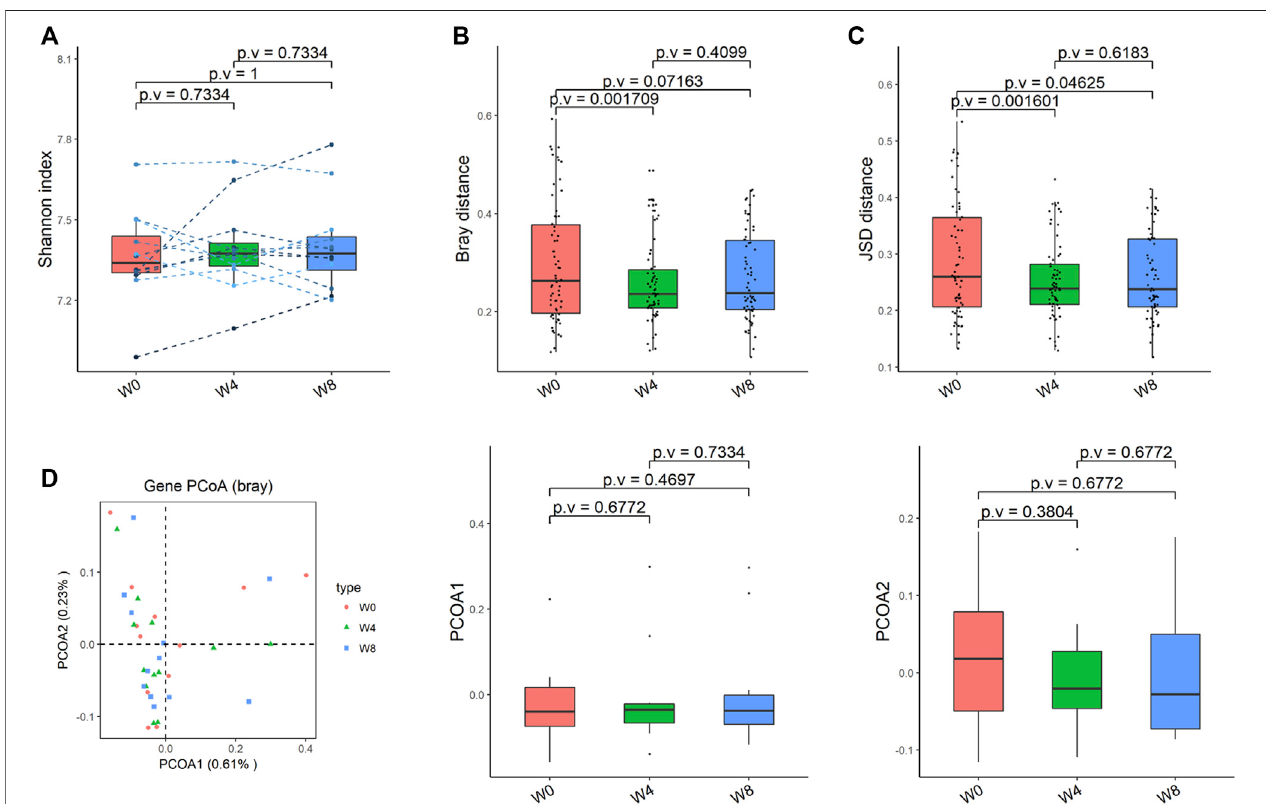
FIGURE 6 | Alpha-diversity, beta-diversity, and principal component analysis at the KO level. (A) Shannon index was not signi fi cantly different in comparisons between W0 and W4, W0 and W8, and W4 and W8. (B) Signi fi cant difference in beta diversity based on Bray-Curtis (Bray) distance for W0 vs W4, but not in W0 vs W8, norW4 vs W8. (C) The Jensen-Shannon Divergence (JSD) distance-based beta diversity was signi fi cantly different in W0 vs W4 and W0 vs W8, but not W4 vs W8. (D) PCoA analysis based on Bray distance showed that the fi rst principal component was not signi fi cantly different in W0 vs W4, W0 vs W8, and W4 vs W8, nor the second